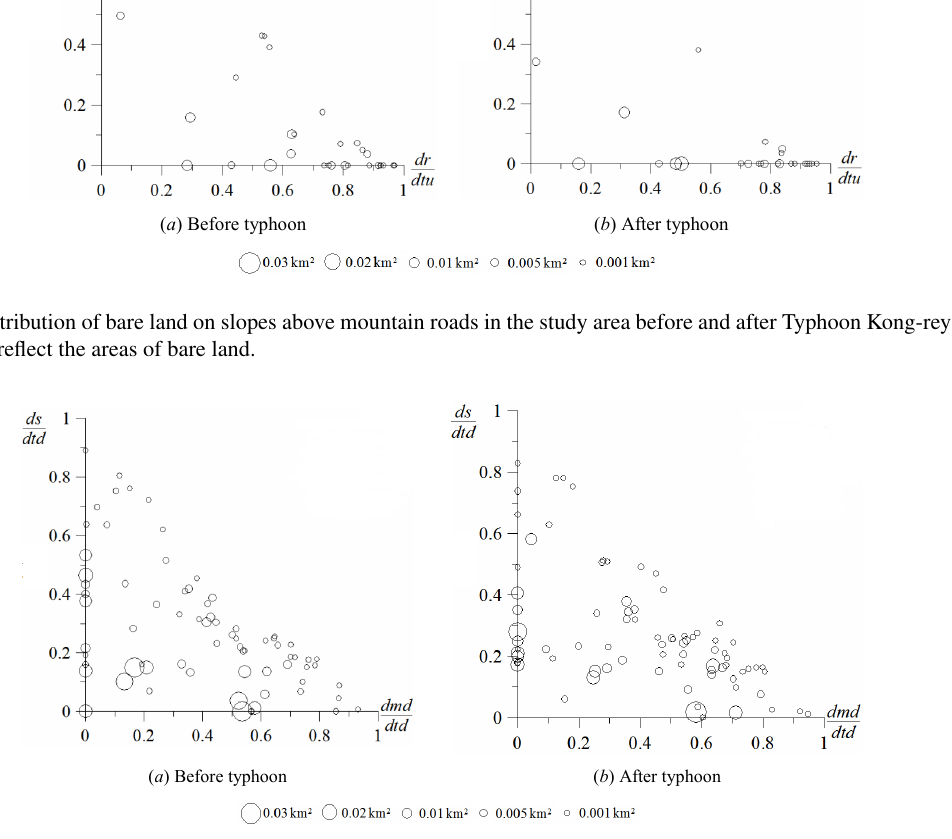
Figure 10: Spatial Distribution of Bare Land on Slopes below Mountain Roads in the Study Area before and after Typhoon Kong- Figure 10. Spatial distribution of bare land on slopes below mountain roads in the study area before and after Typhoon Kong-rey in 2013. rey in 2013, the scales of bubble reflect the area of each bare land. The sizes of the bubbles reflect the areas of bare